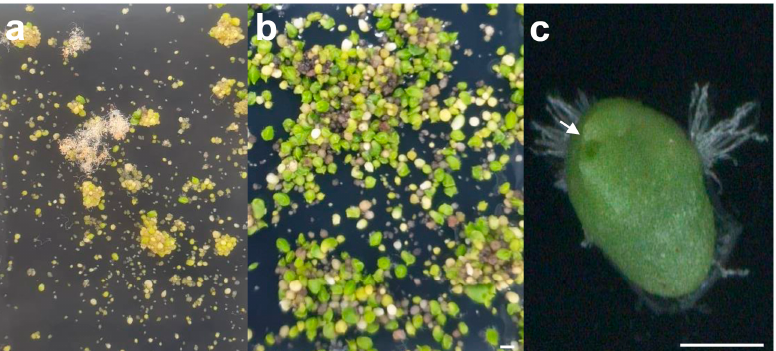
Figure 1. Sedirea japonica seed germination and protocorm development. ( a ) Seed embryos were swollen and seed coats were ruptured one month after sowing; ( b , c ) Shoot apices (indicated by arrows) were formed from embryos two months after sowing. Scale bar = 1 mm.